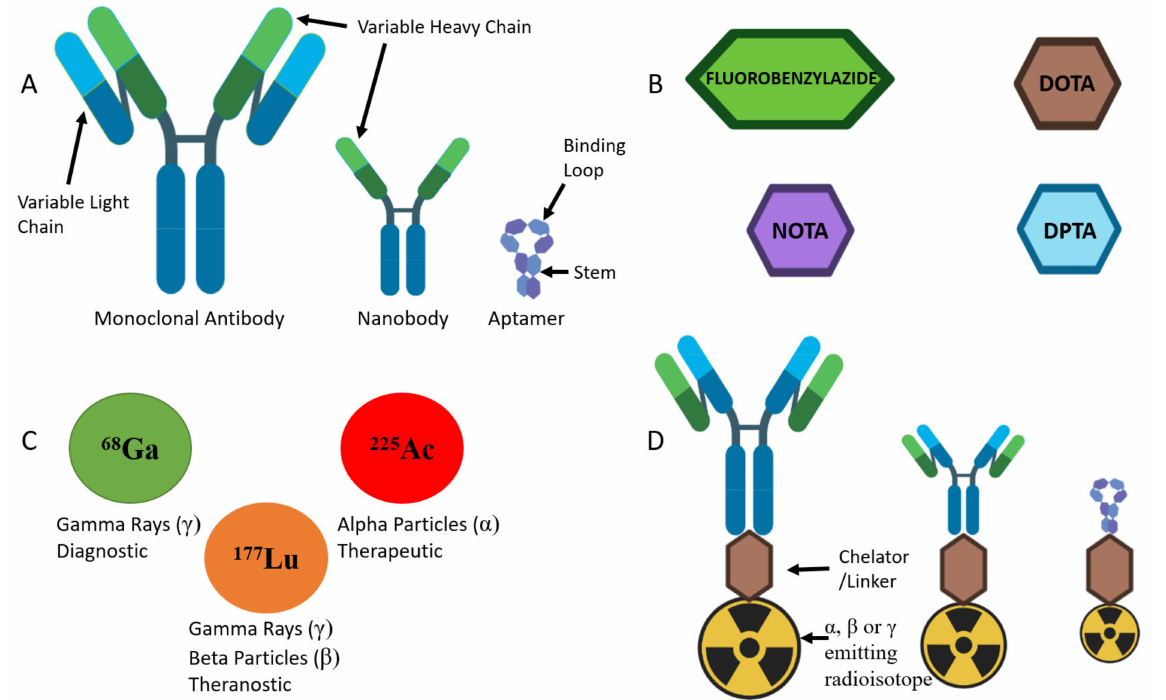
Figure 1. A diagram of targeting ligands, chelators, radionuclides and conjugated radiopharmaceuticals. ( A ) A schematic representation of monoclonal antibody, nanobody and aptamer structures. Antibodies each consist of two identical heavy chains and two identical light chains which are involved in recognising a cognate target. Nanobodies each consist of only two identical heavy chains and lack light chains. Aptamers each contain a binding loop which recognises and binds to the target. ( B ) Commonly used chelators and linkers attach radionuclides to targeting ligands. ( C ) Different types of radioisotopes are used for diagnostic, therapeutic and theranostic applications. ( D ) Radioisotopes are attached to targeting ligands (antibodies, nanobodies, aptamers) with linker molecules, which can then be used for diagnostic, therapeutic or theranostic functions. Adapted from